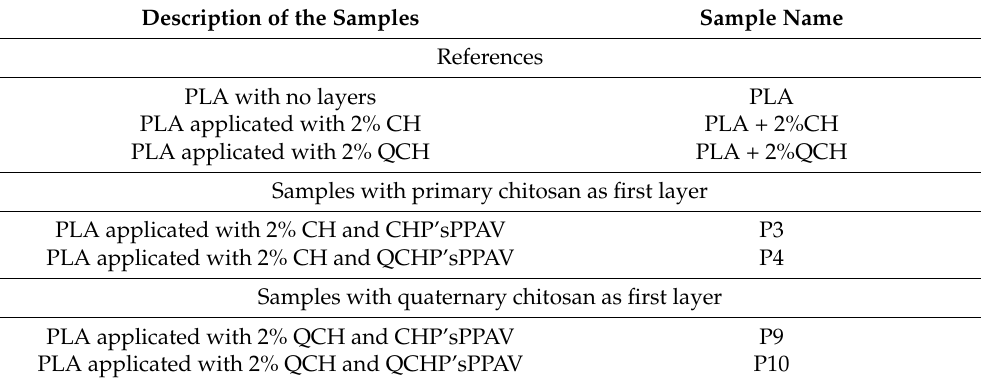
Table 2. PLA film samples